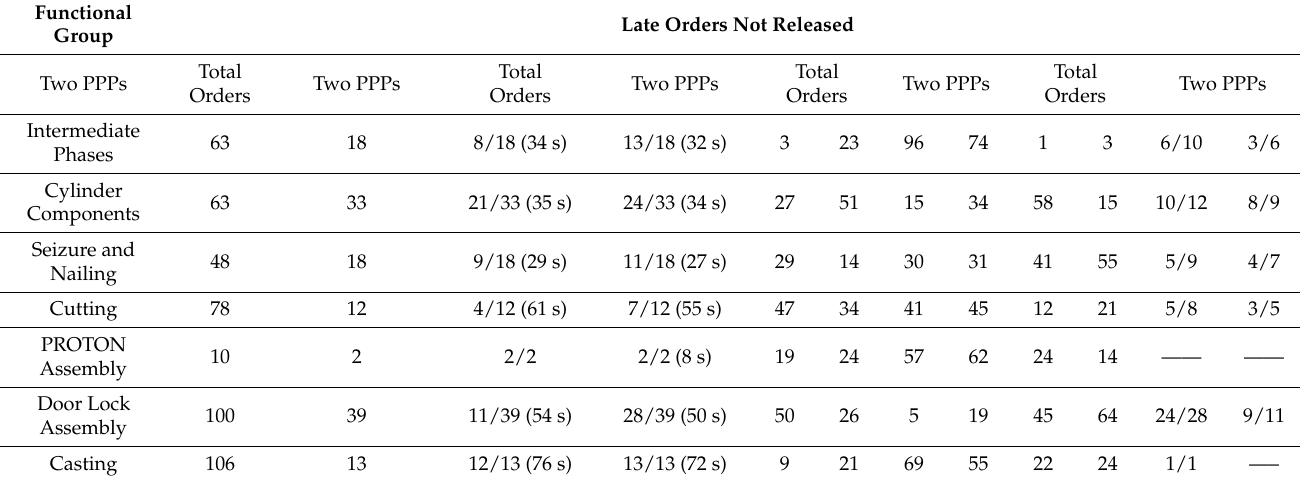
Table 8. Results of TS/VNS-ATM with late orders not